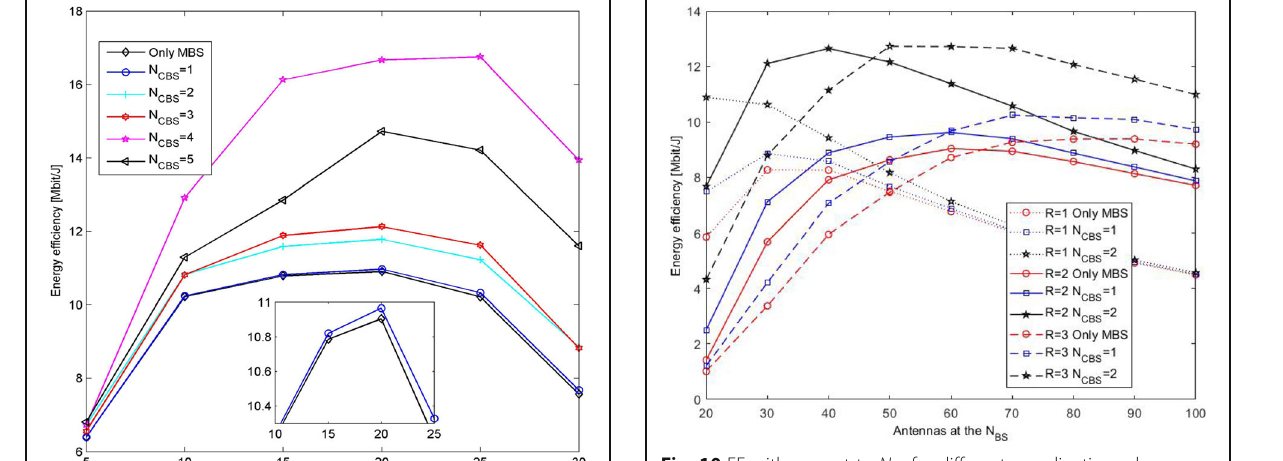
Fig. 10 EE with respect to N BS for different coordination schemes N CBS ∈ {0, 1, 2}, R ∈ {1, 2, 3}, and N S = 4. ------ represents the achievable rate constraints of 3 bit/s/Hz. — represents the achievable rate constraints of 2 bit/s/Hz. …… represents the achievable rate constraints of 1 bit/s/Hz. о represents there is only macro base station and the number of small base station N CBS = 0 . □ represents the number of small base station N CBS = 1 . ☆ represents the number of small base station N CBS =